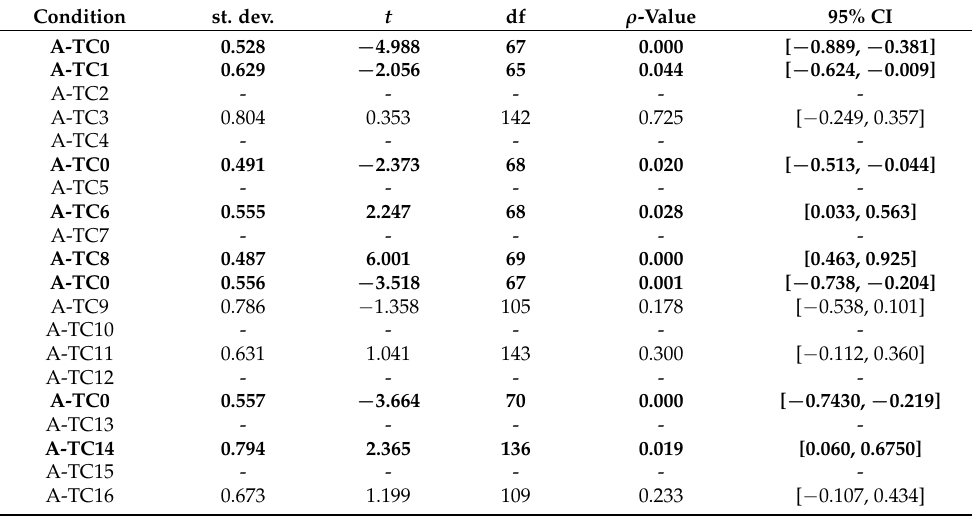
Table 13. Two-sample t -test analysis between equivalent conditions from Experiment 2 and Exper- iment 3 (st. dev.: Standard deviation, t : Test statistic, df: Degrees of freedom). Conditions with statistically significant differences are